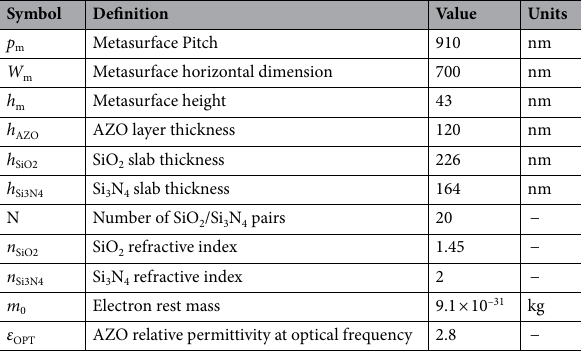
Table 1. The geometrical and physical parameters used in the designed all-optical